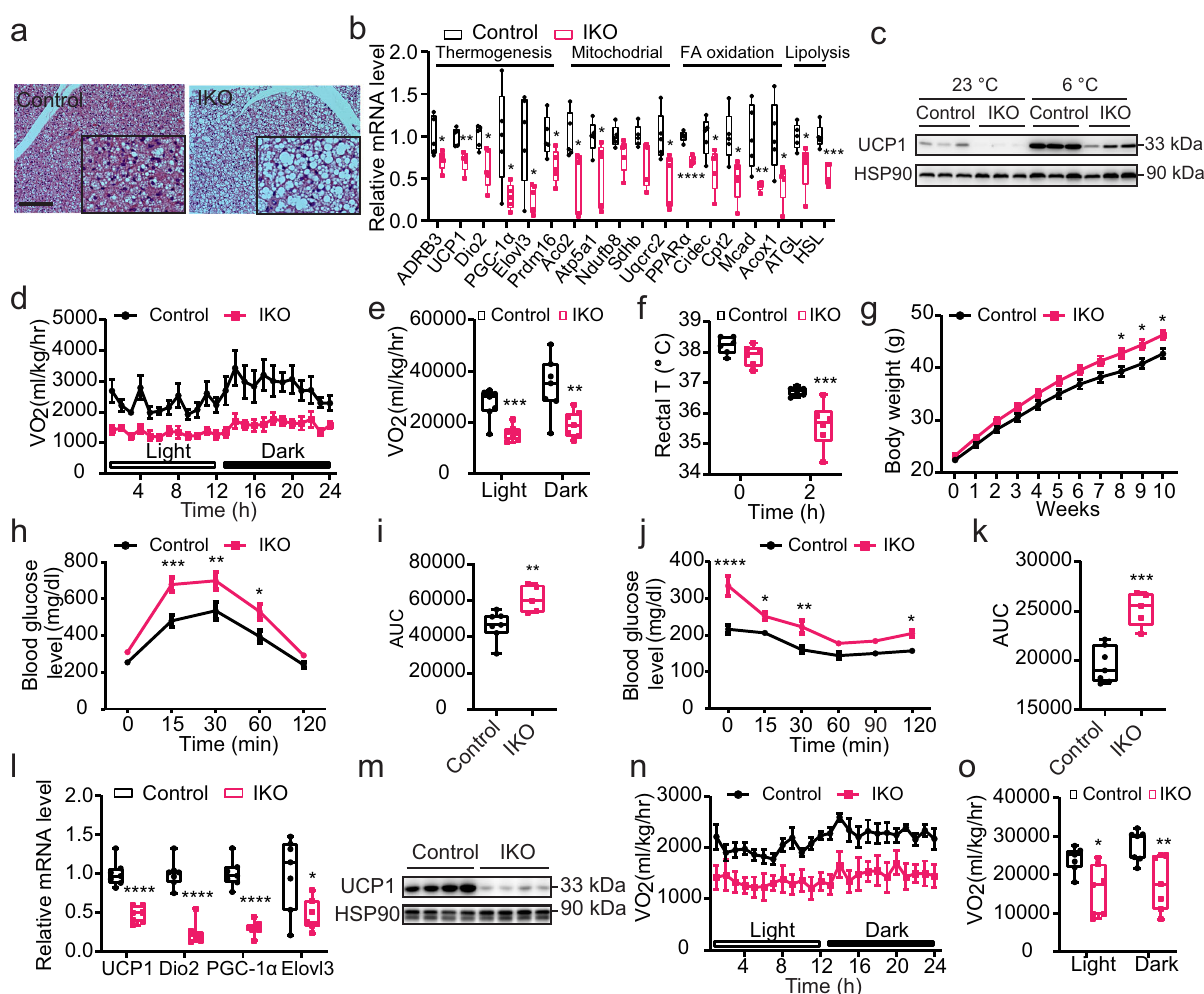
Fig. 1 Intestinal epithelial AMPK knockout mice have impaired BAT function. For a – f , AMPK α 1 fl / fl (Control) and AMPK α 1-IKO mice were fed chow diet. a Representative images of H&E-stained BAT sections. Scale bar = 100 µ m. b Relative mRNA levels of genes in BAT ( n = 5 biologically independent 0.0495, 0.0271, <0.0001, 0.0364, 0.0152, 0.0093, 0.0329, 0.0328, 0.0006. c Western blot analysis of UCP1 protein levels in BAT before and after cold exposure (6 °C) for 1 week. d , e VO2 of mice over 24 h ( n = 7 biologically independent samples). P value: 0.0007, 0.0075. f Rectal temperatures of mice exposed to 6 °C for 2 h ( n = 6 biologically independent samples). P value: 0.0004. For g – o , mice were fed HFD for 10 – 12 weeks. g Body weights of mice during the HFD feeding period. Mice were fed HFD from 6-week-old ( n = 20 biologically independent samples for control group, n = 16 biologically independent samples for IKO group). P value: 0.0326, 0.0197, 0.0209. h , i Glucose tolerance test results at 10 weeks of HFD feeding ( n = 7 biologically independent samples for control group, n = 5 group). P value for h : 0.0004, 0.0047, 0.0255. P value for i : 0.0088. j , k Insulin tolerance test results at 11 weeks of HFD feeding ( n = 7 biologically independent samples for control group, n = 5 biologically independent samples for IKO group). P value for j : <0.0001, 0.0301, 0.0011, 0.0225. P value for k : 0.0003. l Relative mRNA levels of thermogenesis genes in BAT ( n = 7 biologically independent samples). P value: <0.0001, <0.0001, <0.0001, 0.0165. m UCP1 protein levels in BAT. n , o VO2 of mice over 24 h ( n = 7 biologically independent samples). P value: 0.0119, 0.0079. Values are means ± s.e.m. for d , g , h , j , n . The boxplot elements (for b , e , f , i , k , l , and o ) are de fi ned as following: center line, median;